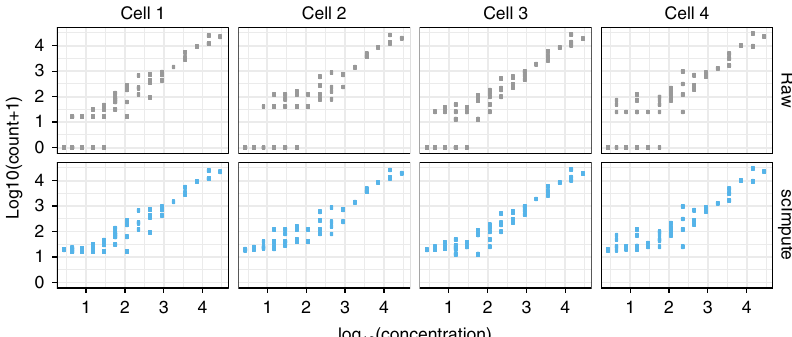
Fig. 2 scImpute improves the dropouts in the ERCC RNA transcripts. The y -axis and x -axis give the ERCC spike-ins ’ log 10 (count + 1) and log 10 (concentration) in four randomly selected mouse cortex cells. The imputed data present stronger linear relationships between the true concentrations and the observed